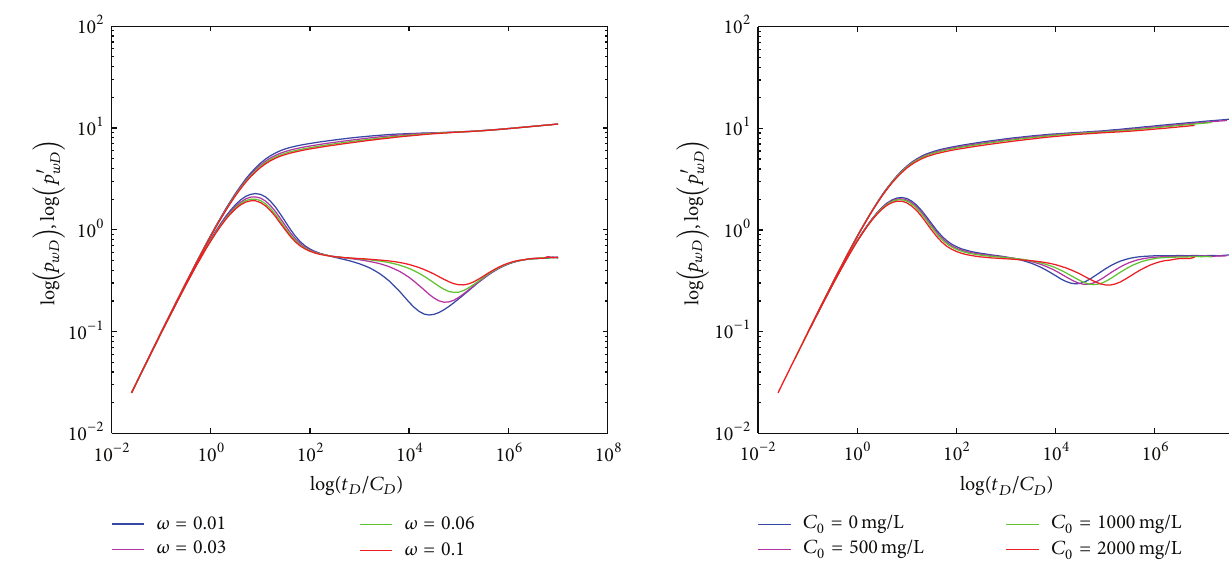
Figure 8: Effect of initial polymer concentration ( 𝐶 𝑝0 ) on type curves.